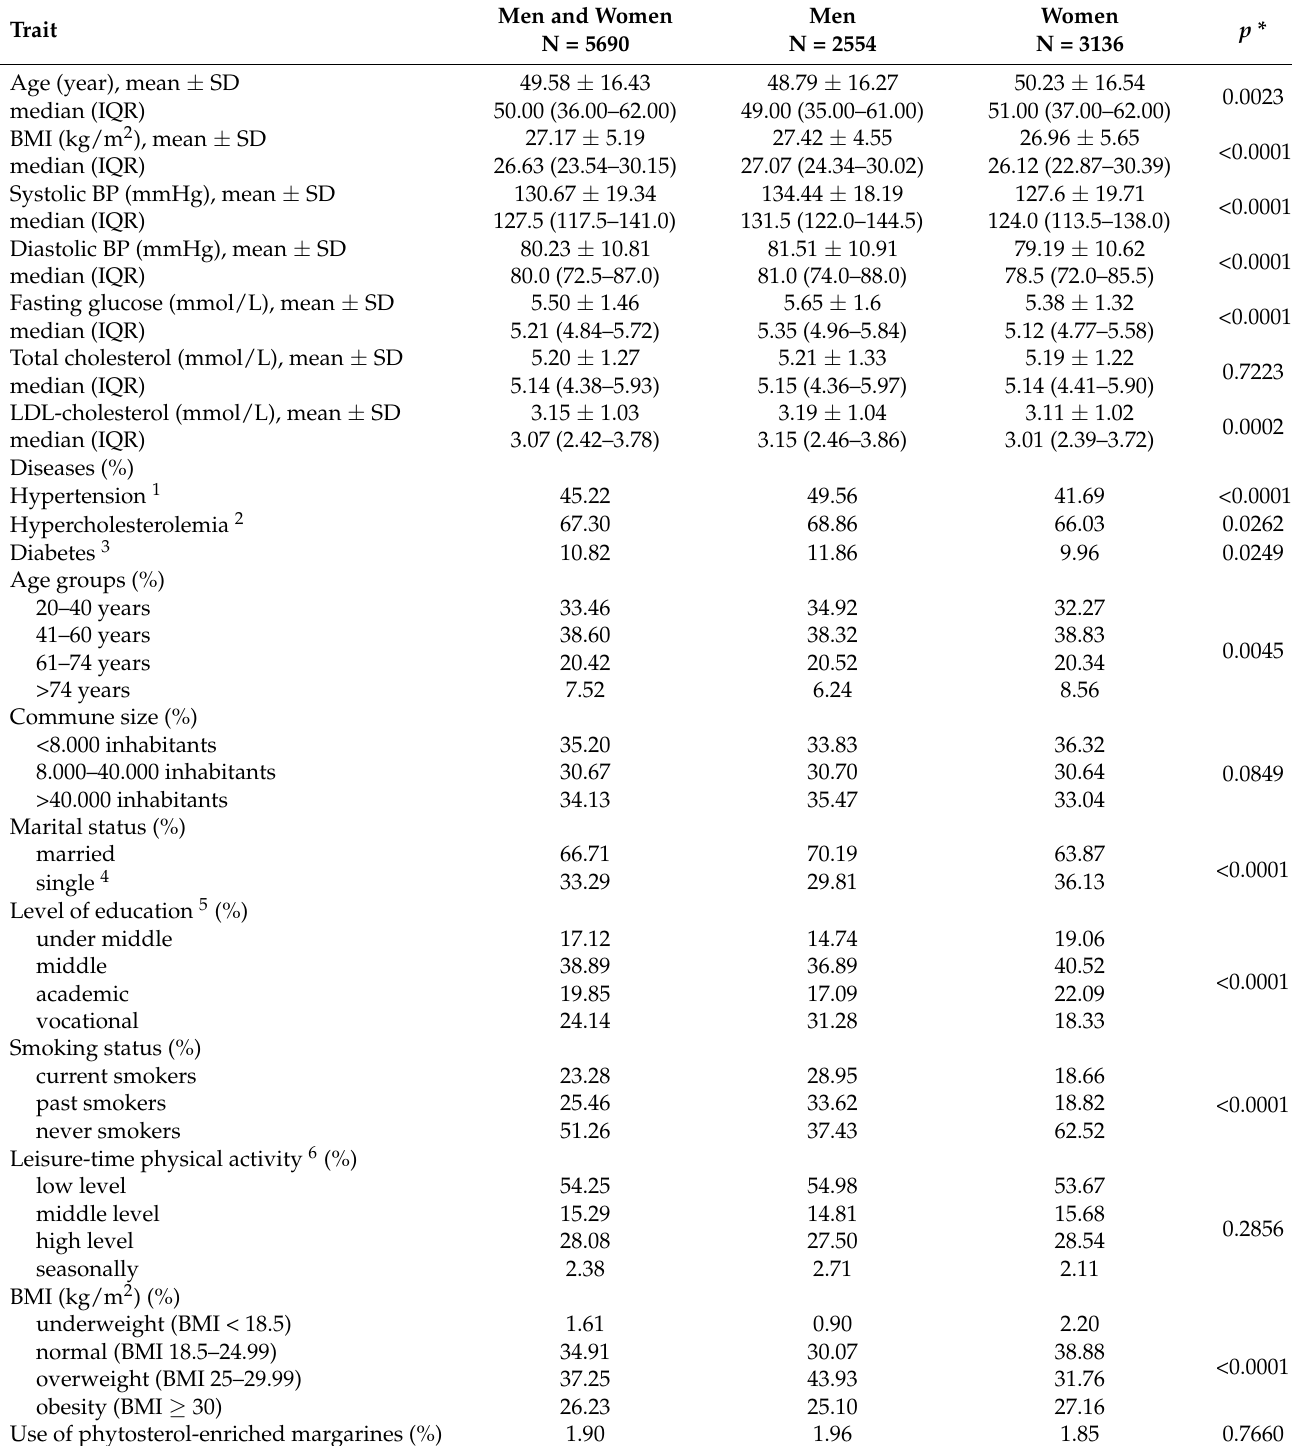
Table 1. General description of the studied